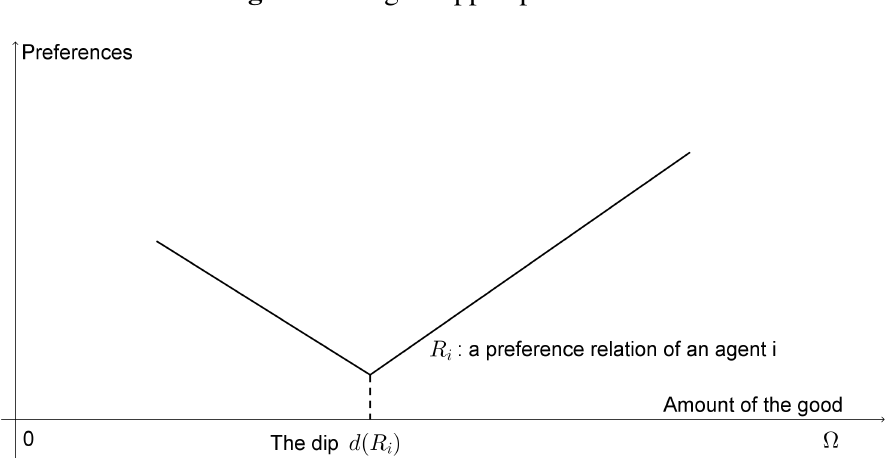
Figure 1. Single-dipped